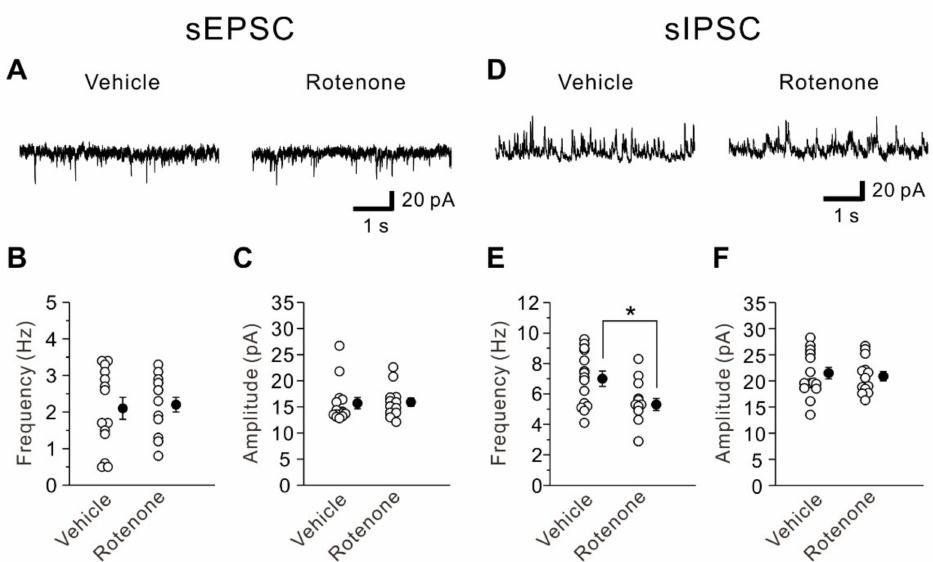
Figure 3. Impairment of inhibitory synaptic transmission caused by intranasal administration of rotenone. ( A ) Representative traces of sEPSCs obtained from layer V pyramidal neurons of vehicle- treated mice (left) and rotenone-treated mice (right). ( B , C ) Summary scatter plots of sEPSC frequency ( B ) and amplitude ( C ) obtained from vehicle-treated mice ( n = 14) and rotenone-treated mice ( n = 14). ( D ) Representative traces of sIPSCs obtained from layer V pyramidal neurons of vehicle-treated mice (left) and rotenone-treated mice (right). ( E , F ) Summary scatter plots of sIPSC frequency ( E ) and amplitude ( F ) obtained from vehicle-treated mice ( n = 15) and rotenone-treated mice ( n = 13). Unpaired t -test, *: p <